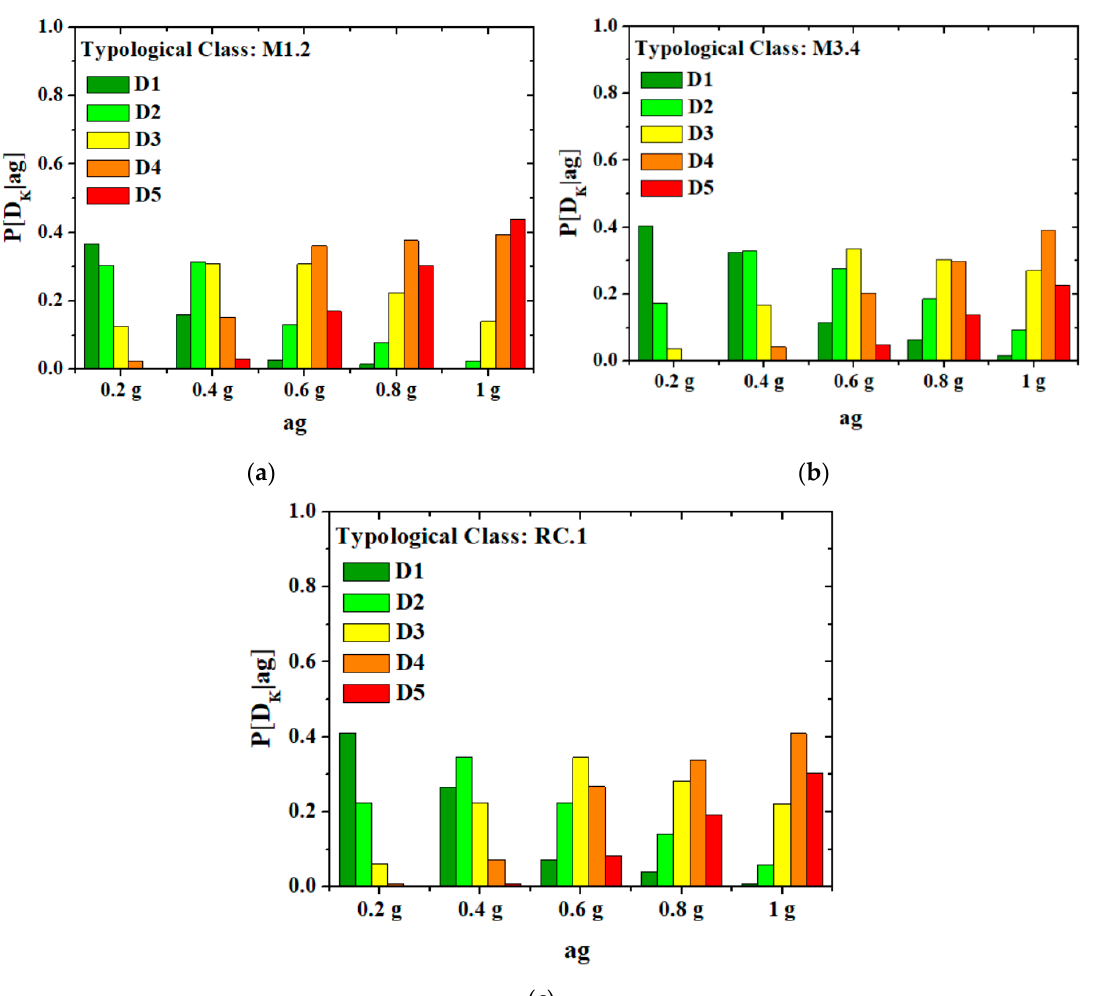
Figure 15. Expected damage distributions for the analysed typological classes at different values of a g . ( a ) M1.2; ( b ) M3.4; ( c ) RC.1.